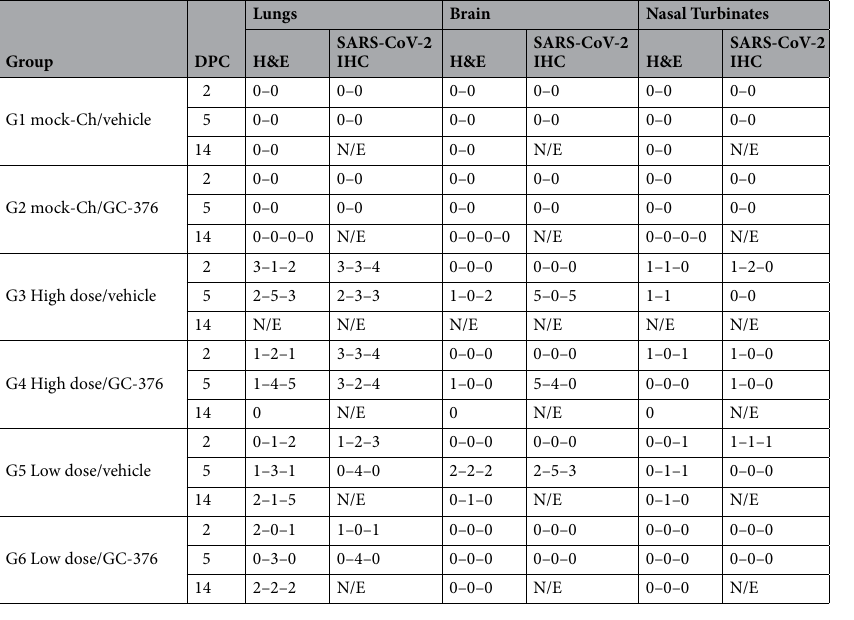
Table 1. HE and SARS-CoV-2 IHC scores of different treatment groups. N/E not evaluated. A dash (–) is used to separate the score of each individual mouse evaluated in each